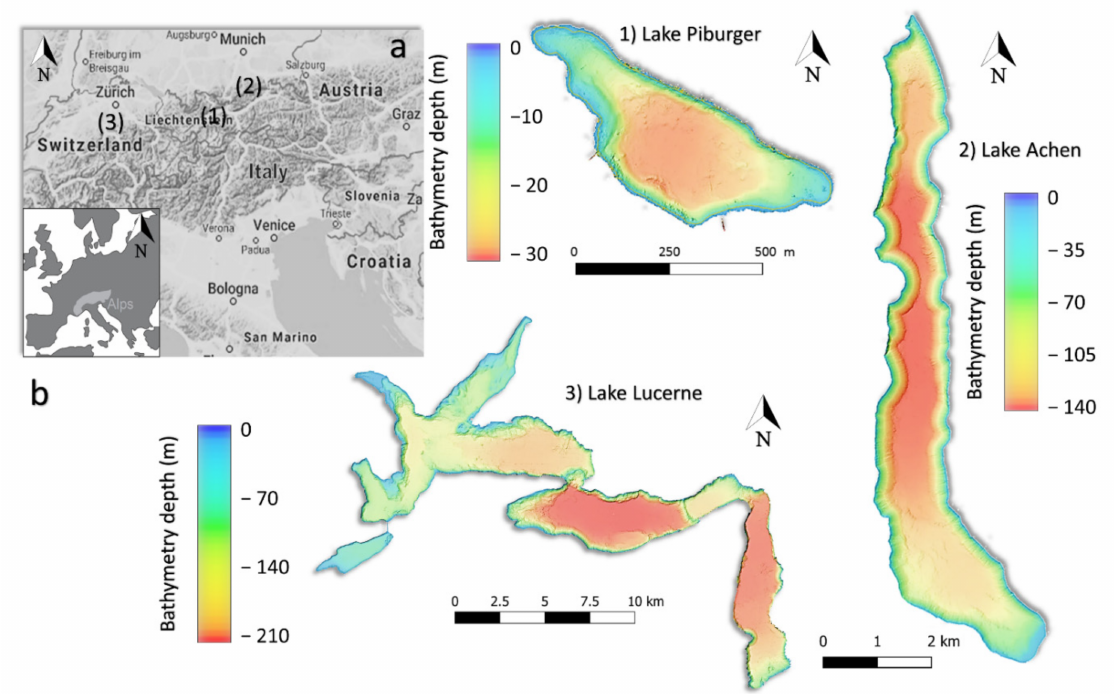
Figure 1. Examples of mountain lakes, differing in shape, bathymetry, and spatial extent. ( a ) Location of the presented lakes in the Alps region. ( b ) Examples of diverse lake geometries: Lake Piburger (1-Austria), Lake Achen (2-Austria), and Lake Lucerne (3-Switzerland). Bathymetric data provided by the Sedimentary Geology Working Group of the University of Innsbruck [19,20] and the Swiss Service-Federal Office of Topography swisstopo (https://www.swisstopo.admin.ch/ en/geodata/height/bathy3d.html) (Accessed on 3 September 2021), [21,22]. The topographical background is taken from Microsoft Bing Maps—2021 Microsoft Corporation Earthstar Geographics Sio (Accessed on 26 July